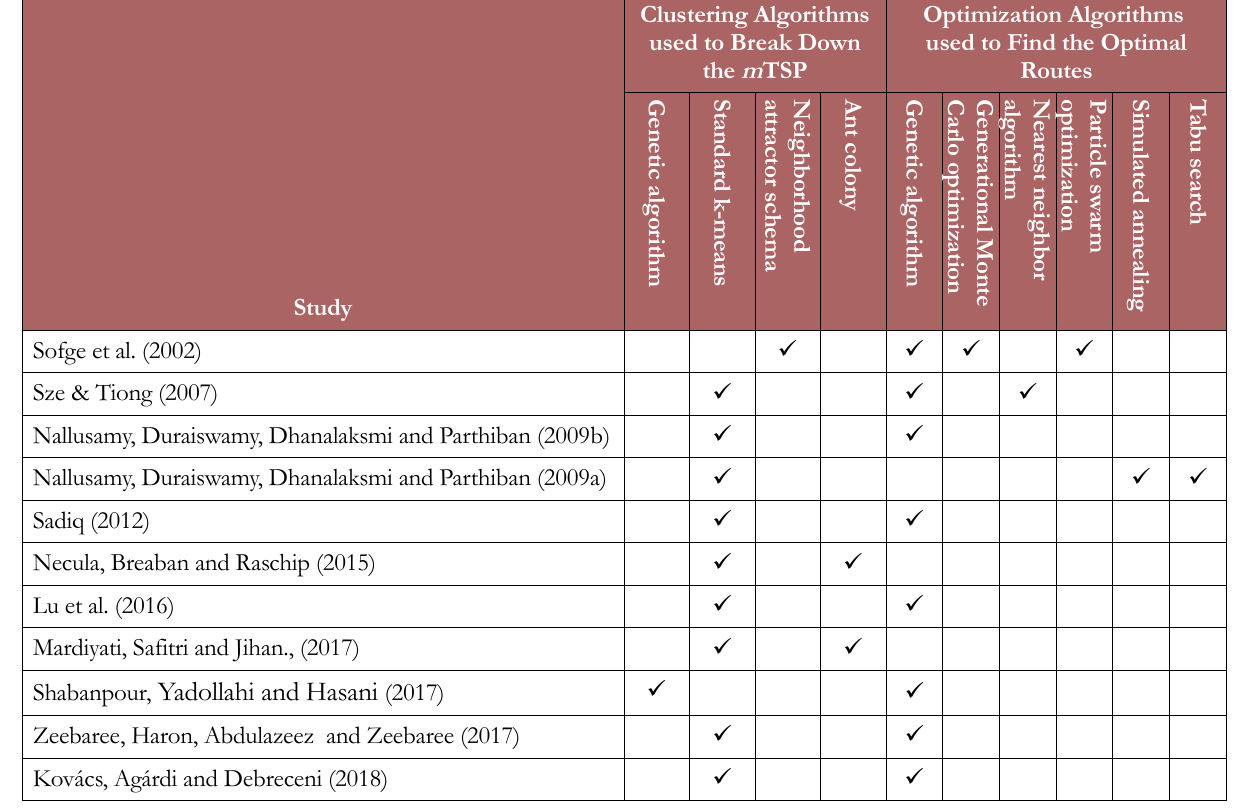
Table 1. The clustering and optimization algorithms used in various studies